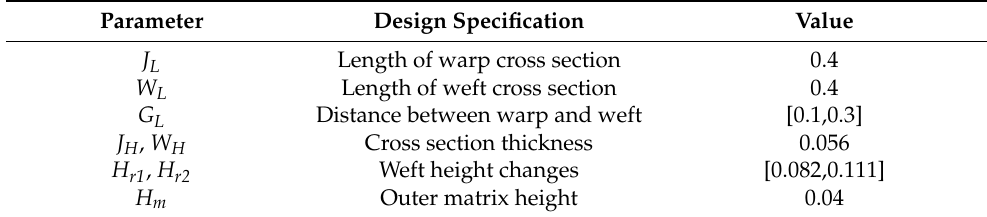
Table 2. Geometric design parameters of uncertainty model.